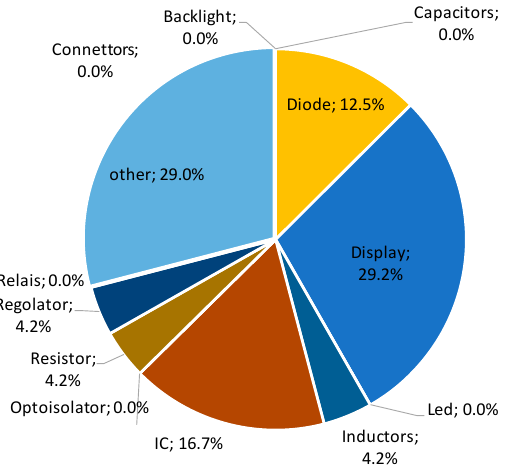
Figure 10. Contribution to the failure rate of the TFT board of the different types of components, derived from experimental data.